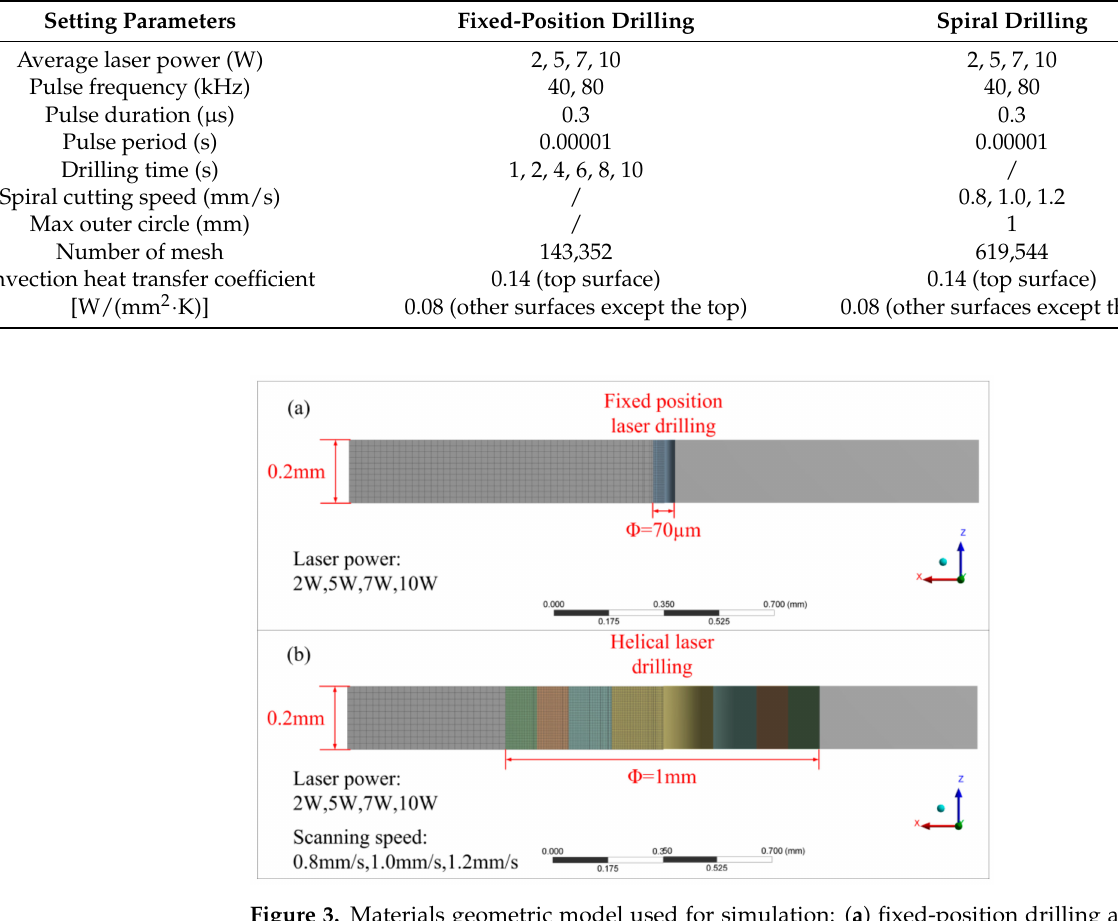
Figure 3. Materials geometric model used for simulation: ( a ) fixed-position drilling and ( b ) heli- cal